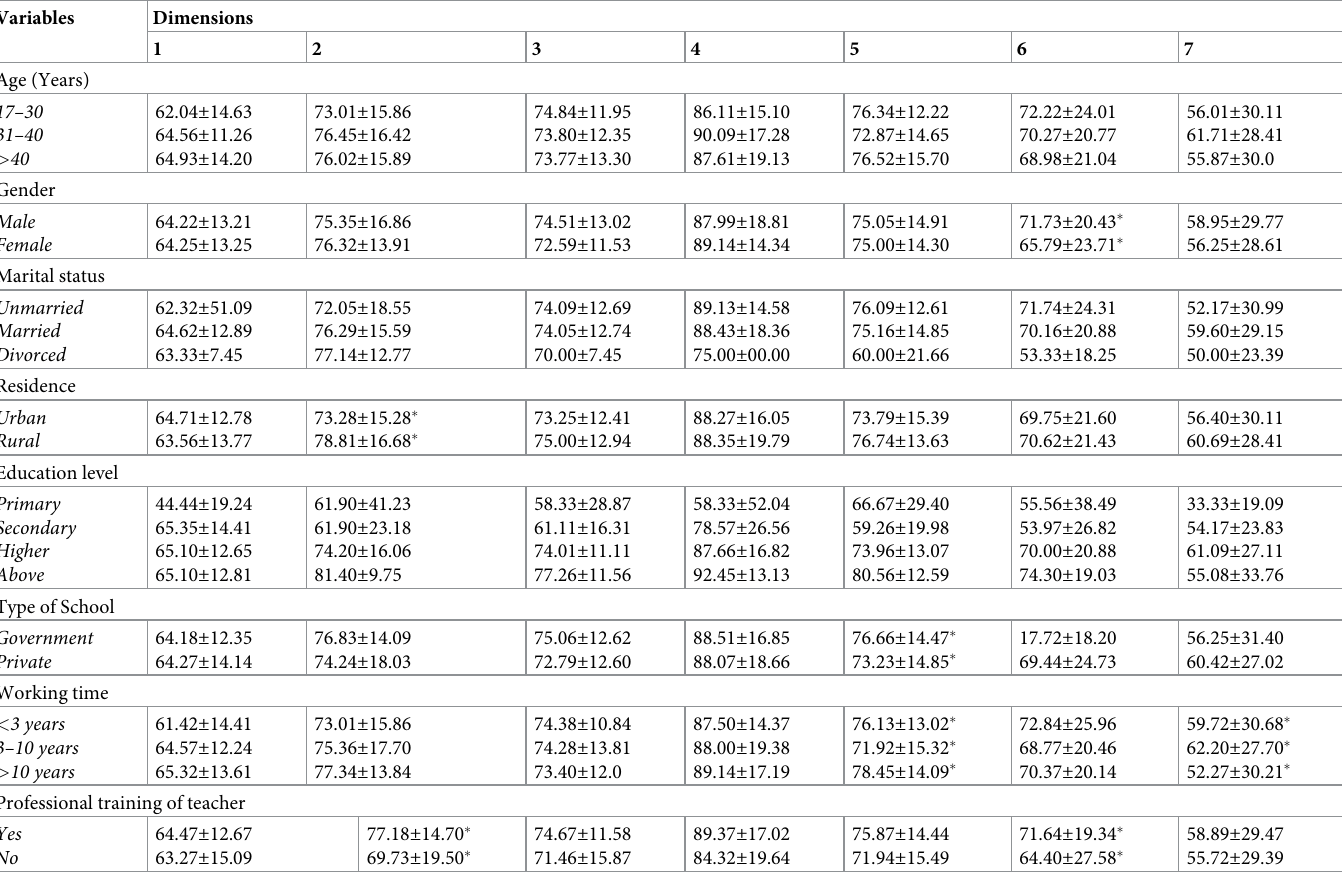
Table 2. Average score of each dimension of knowledge in different variables (mean,